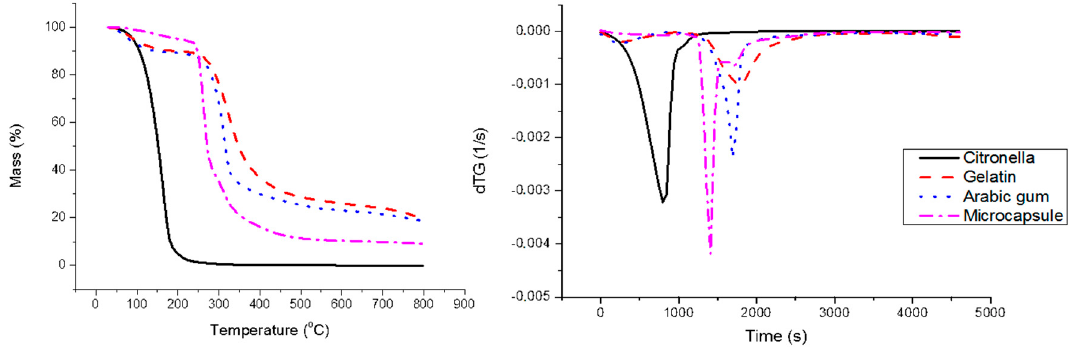
Figure 3. TGA/DTGA thermogram for different components of the system.